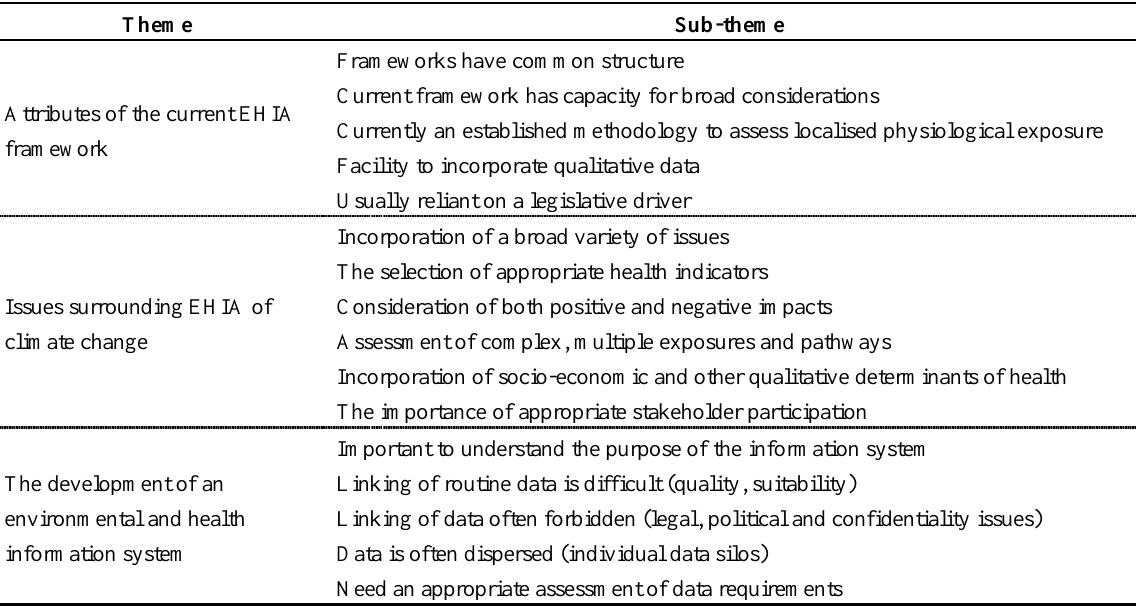
Table 3. Main findings from focus group